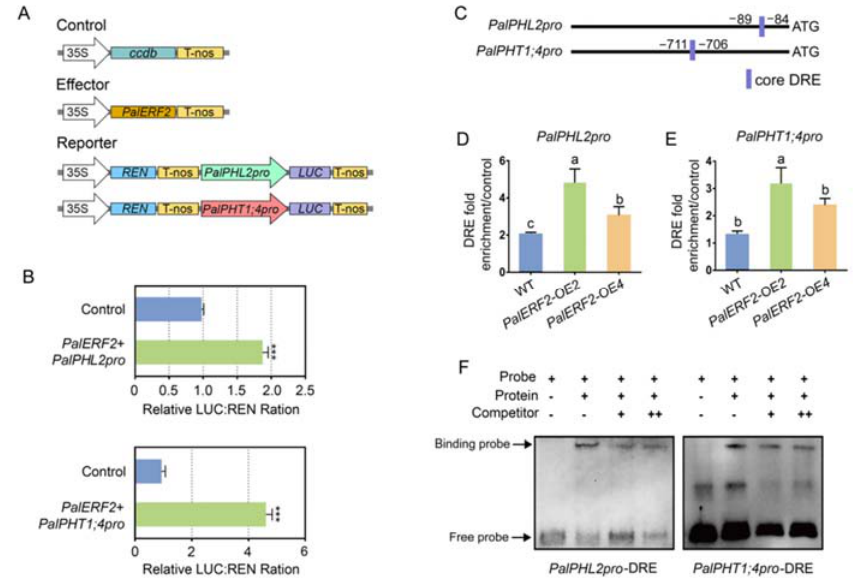
Figure 3. PalERF2 regulates PalPHL2 and PalPHT1;4 expression. ( A ) Structures of effector and reporters employed in dual-luciferase assay. ( B ) Transient co-expression of effector and reporter vectors in Nicotiana benthamiana leaves for dual-luciferase assay. Error bars indicate SD values ( n =